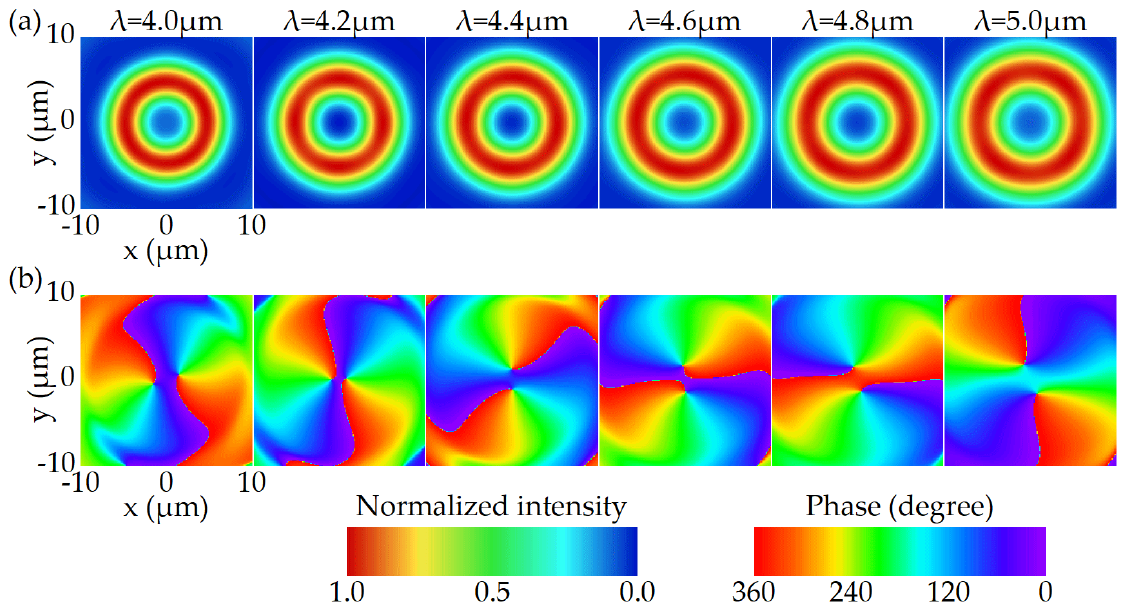
Figure A3. The simulated electric field distribution for the FVBG with zero dispersion on the focal plane between 4.0 and 5.0 μ m at l = 2. ( a ) Normalized intensity. ( b ) Phase.